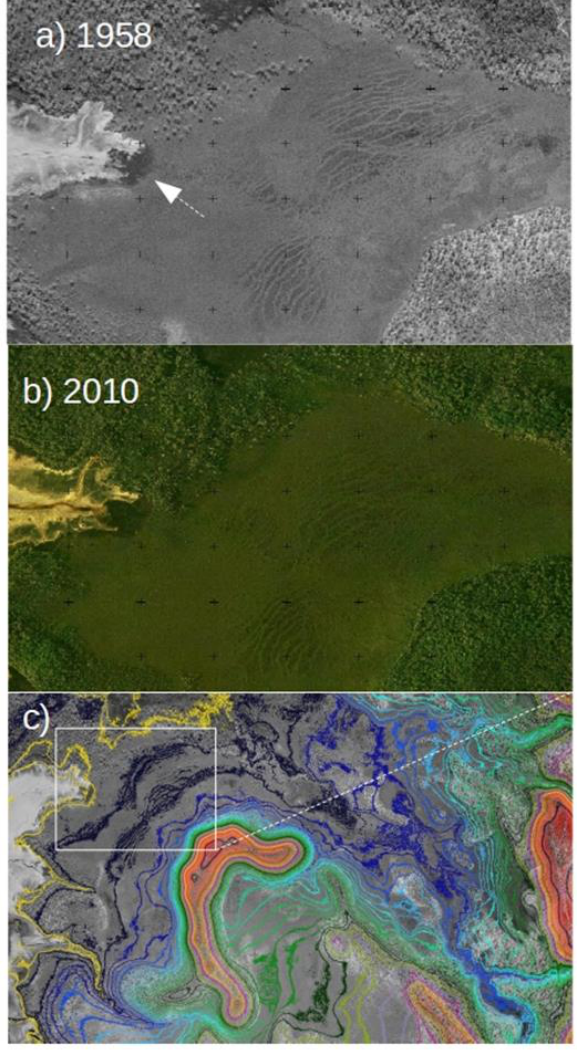
Figure 2. Aerial imagery of a fen with linear ‘string fen’ patterning adjoining a tidal mudflat near Rainbow Beach, Cooloola (153.046 °E, 25.953 °S). Tick marks on a) and b) represent 200 m intervals. Darker shades within the pattern represent open water. On panel c), altitude is represented by 1 m contours, where yellow represents 1 and 2 m a.s.l, dark blue 3 and 4 m a.s.l. etc. The top of the central sand ridge is at 50 m a.s.l. 2010 imagery and altitude data courtesy of State of Queensland (Department of Science, Information Technology, Innovation and the Arts)